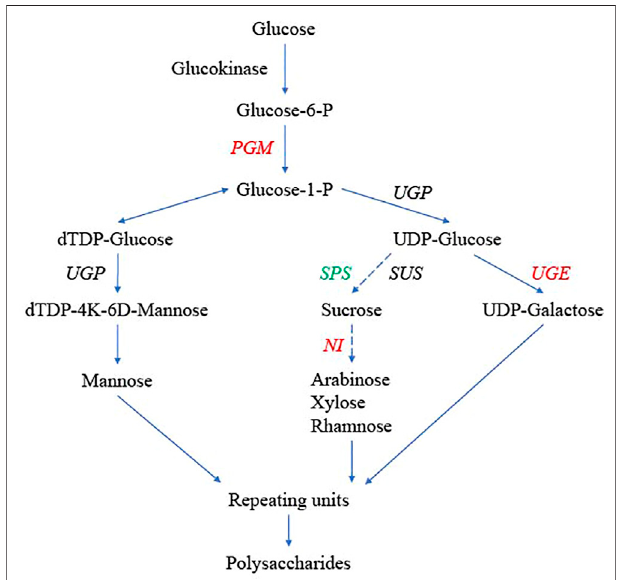
FIGURE 7 | Genes in the polysaccharide synthesis pathway in Dendrobium nobile , adapted from Wang (Wang et al., 2020). Hydrolysis or hydrolysis-derived reactions could generate monosaccharides, such as mannose, glucose, and galactose. These monosaccharides are also the basic building blocks and repeating units for synthesizing polysaccharides. Genes in red indicate gene copy number variation among D. nobile , Dendrobium catenatum , Dendrobium chrysotoxum , Phalaenopsis equestris , Apostasia shenzhenica , and Arabidopsis thaliana . Genes in green are Dendrobium- speci fi c. The dashed lines indicate multiple